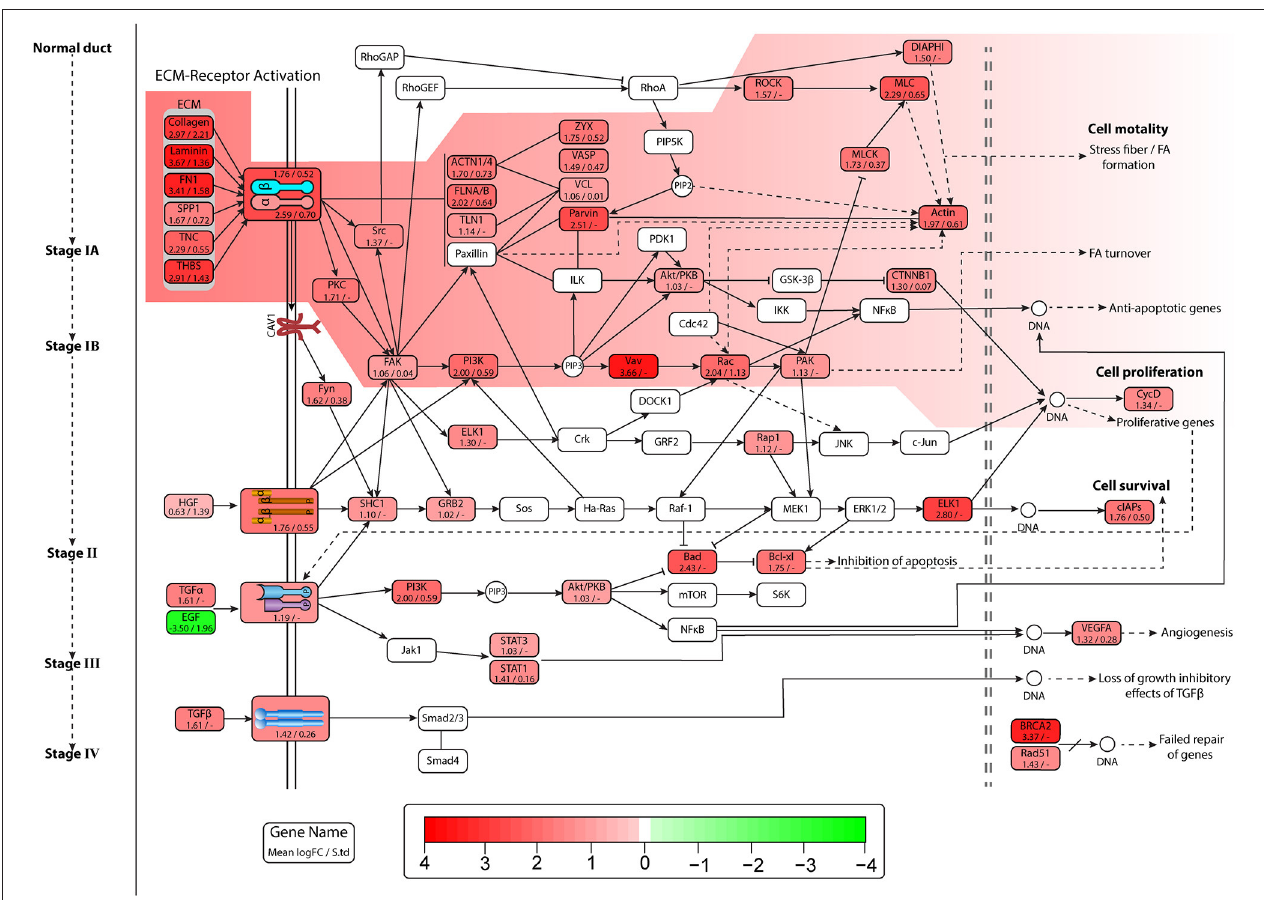
FIGURE 4 | Figure represents expression of genes, and each entity contains name of gene mean Log 2 FC value and standard deviation of Log 2 FC values in all datasets. Pathway image is similar to Figure 3 depicting pancreatic cancer (PaCa) progression signaling in cell. Entities in the highlighted path show high overexpression, and lead to lamellipodia formation and initiation of proliferative gene